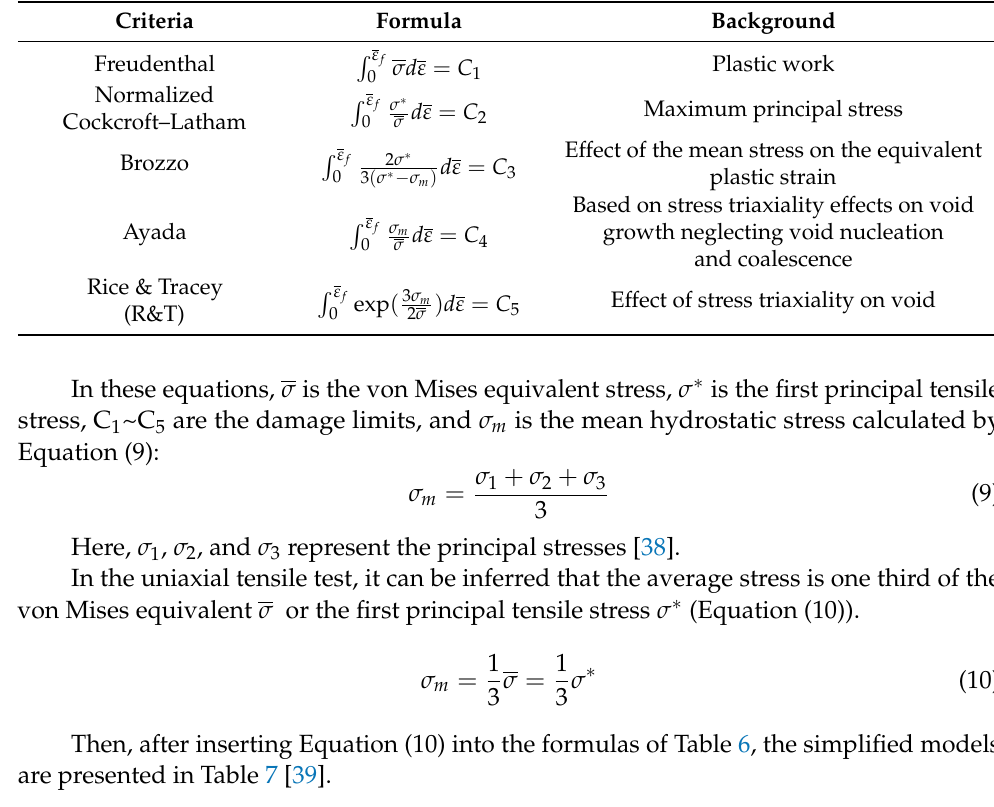
Table 6. Brief summary of selected typical uncoupled